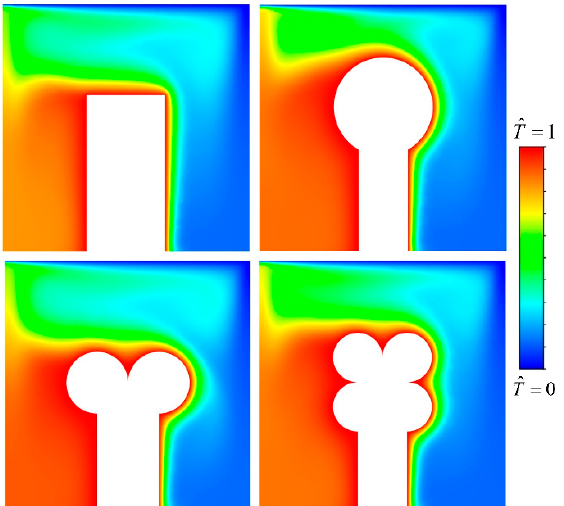
Figure 9. Thermal contours for each of the fins at Re = 100 and Ra = 10 6 , showing how strong gravity leads to a less even temperature spread.